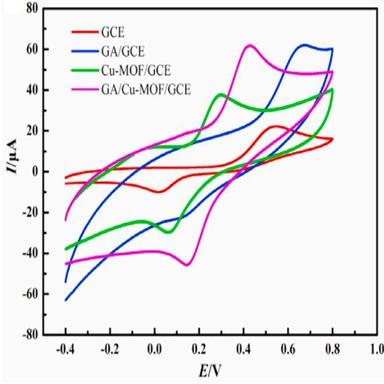
Cyclic voltammetry curves for similar Trace catechol (CT) concentration in phosphate buffer solution using different systems.